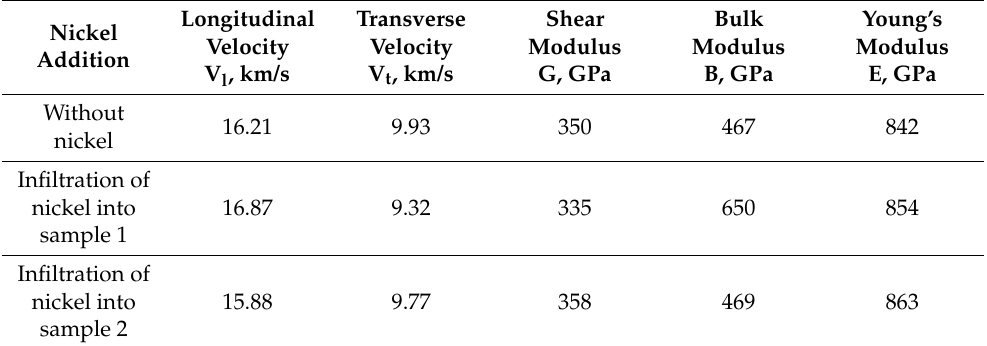
Table 1. Elastic moduli of composites obtained from FDM-2Al-6Co and nickel at 7.5 GPa and 1550 °C.